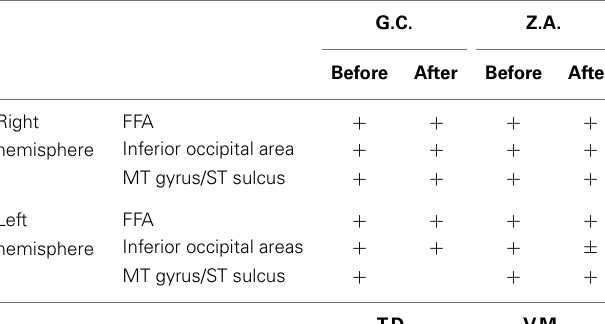
Table 2 | Main activated regions for faces before and after lobectomy in left MTLE patients